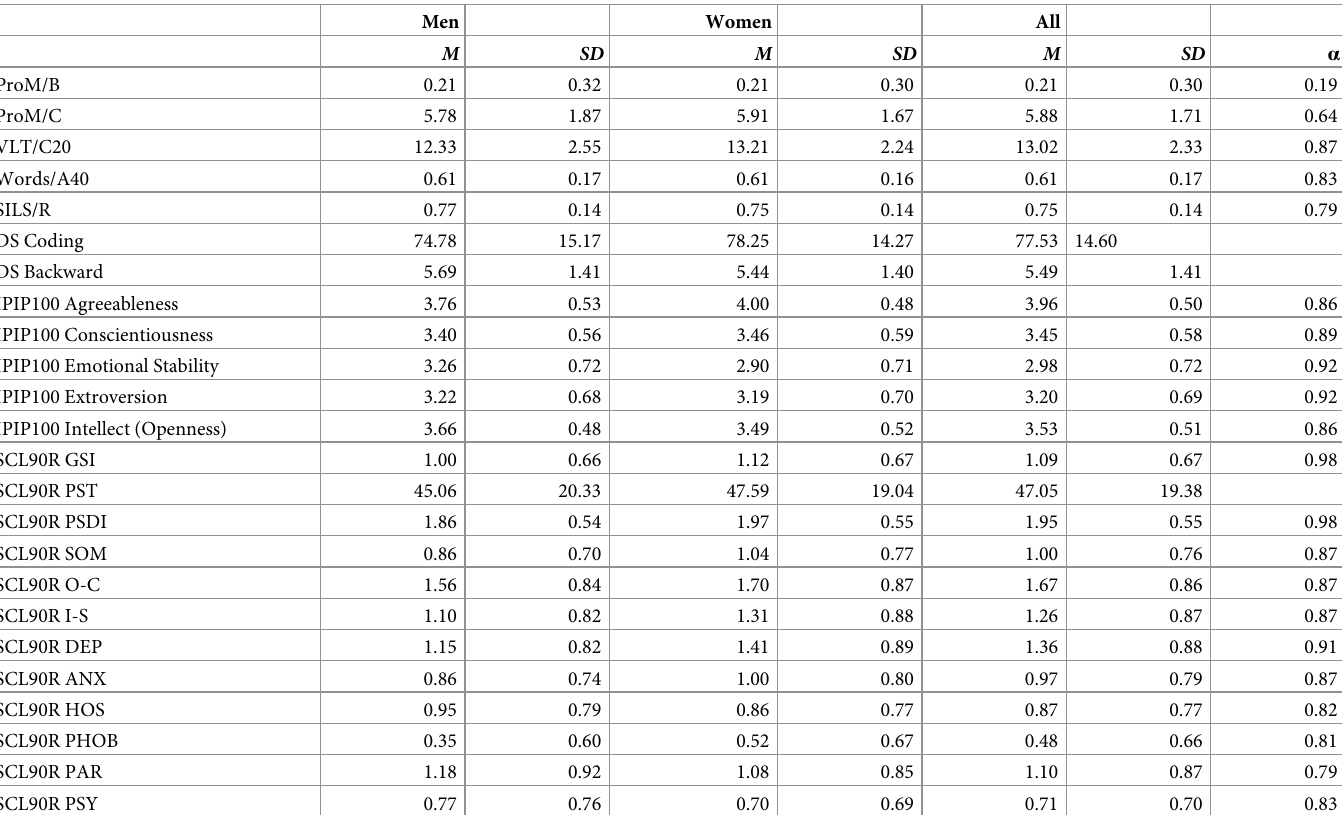
Table 2. Descriptive statistics and